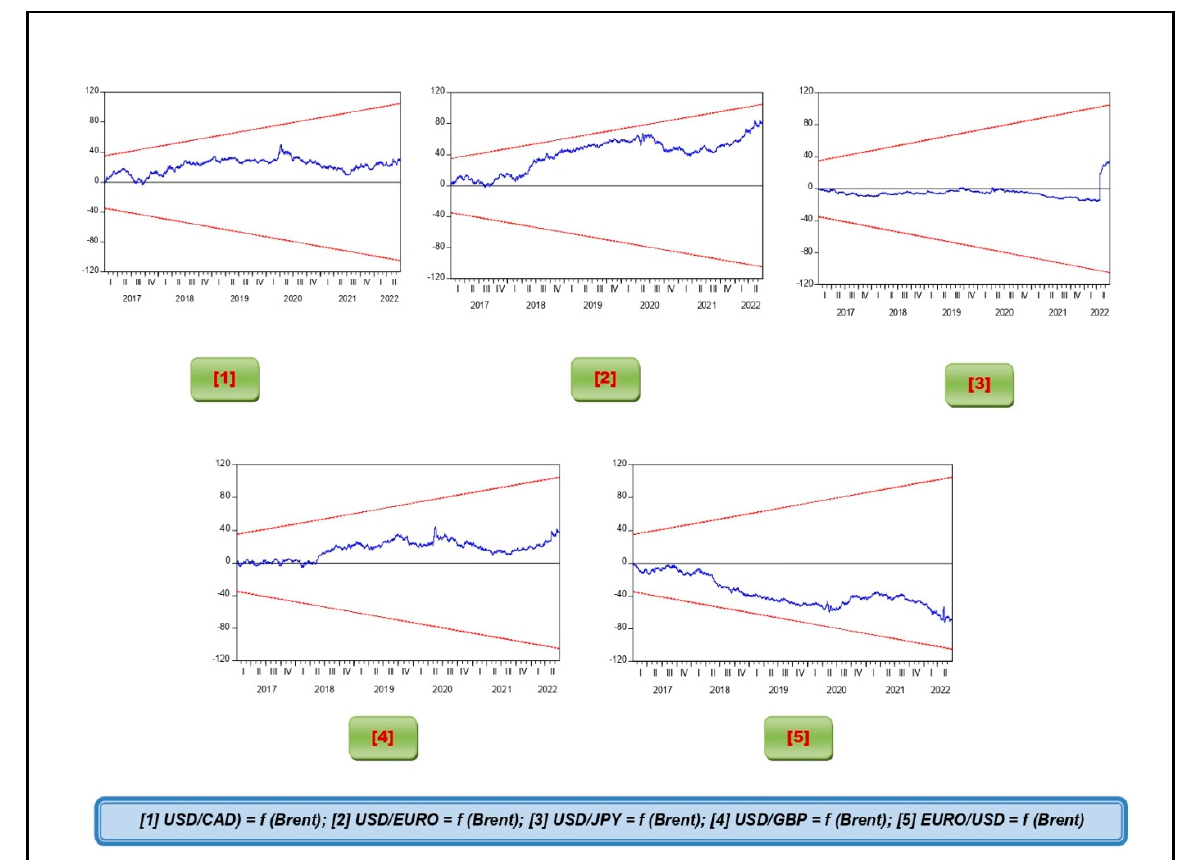
Figure 2. Plots of CUSUM for Parameter Stability between Brent Crude Oil Price and Exchange Rates of the domestic currencies of G7 countries expressed in terms of USD. Source: Researchers’ own representations.